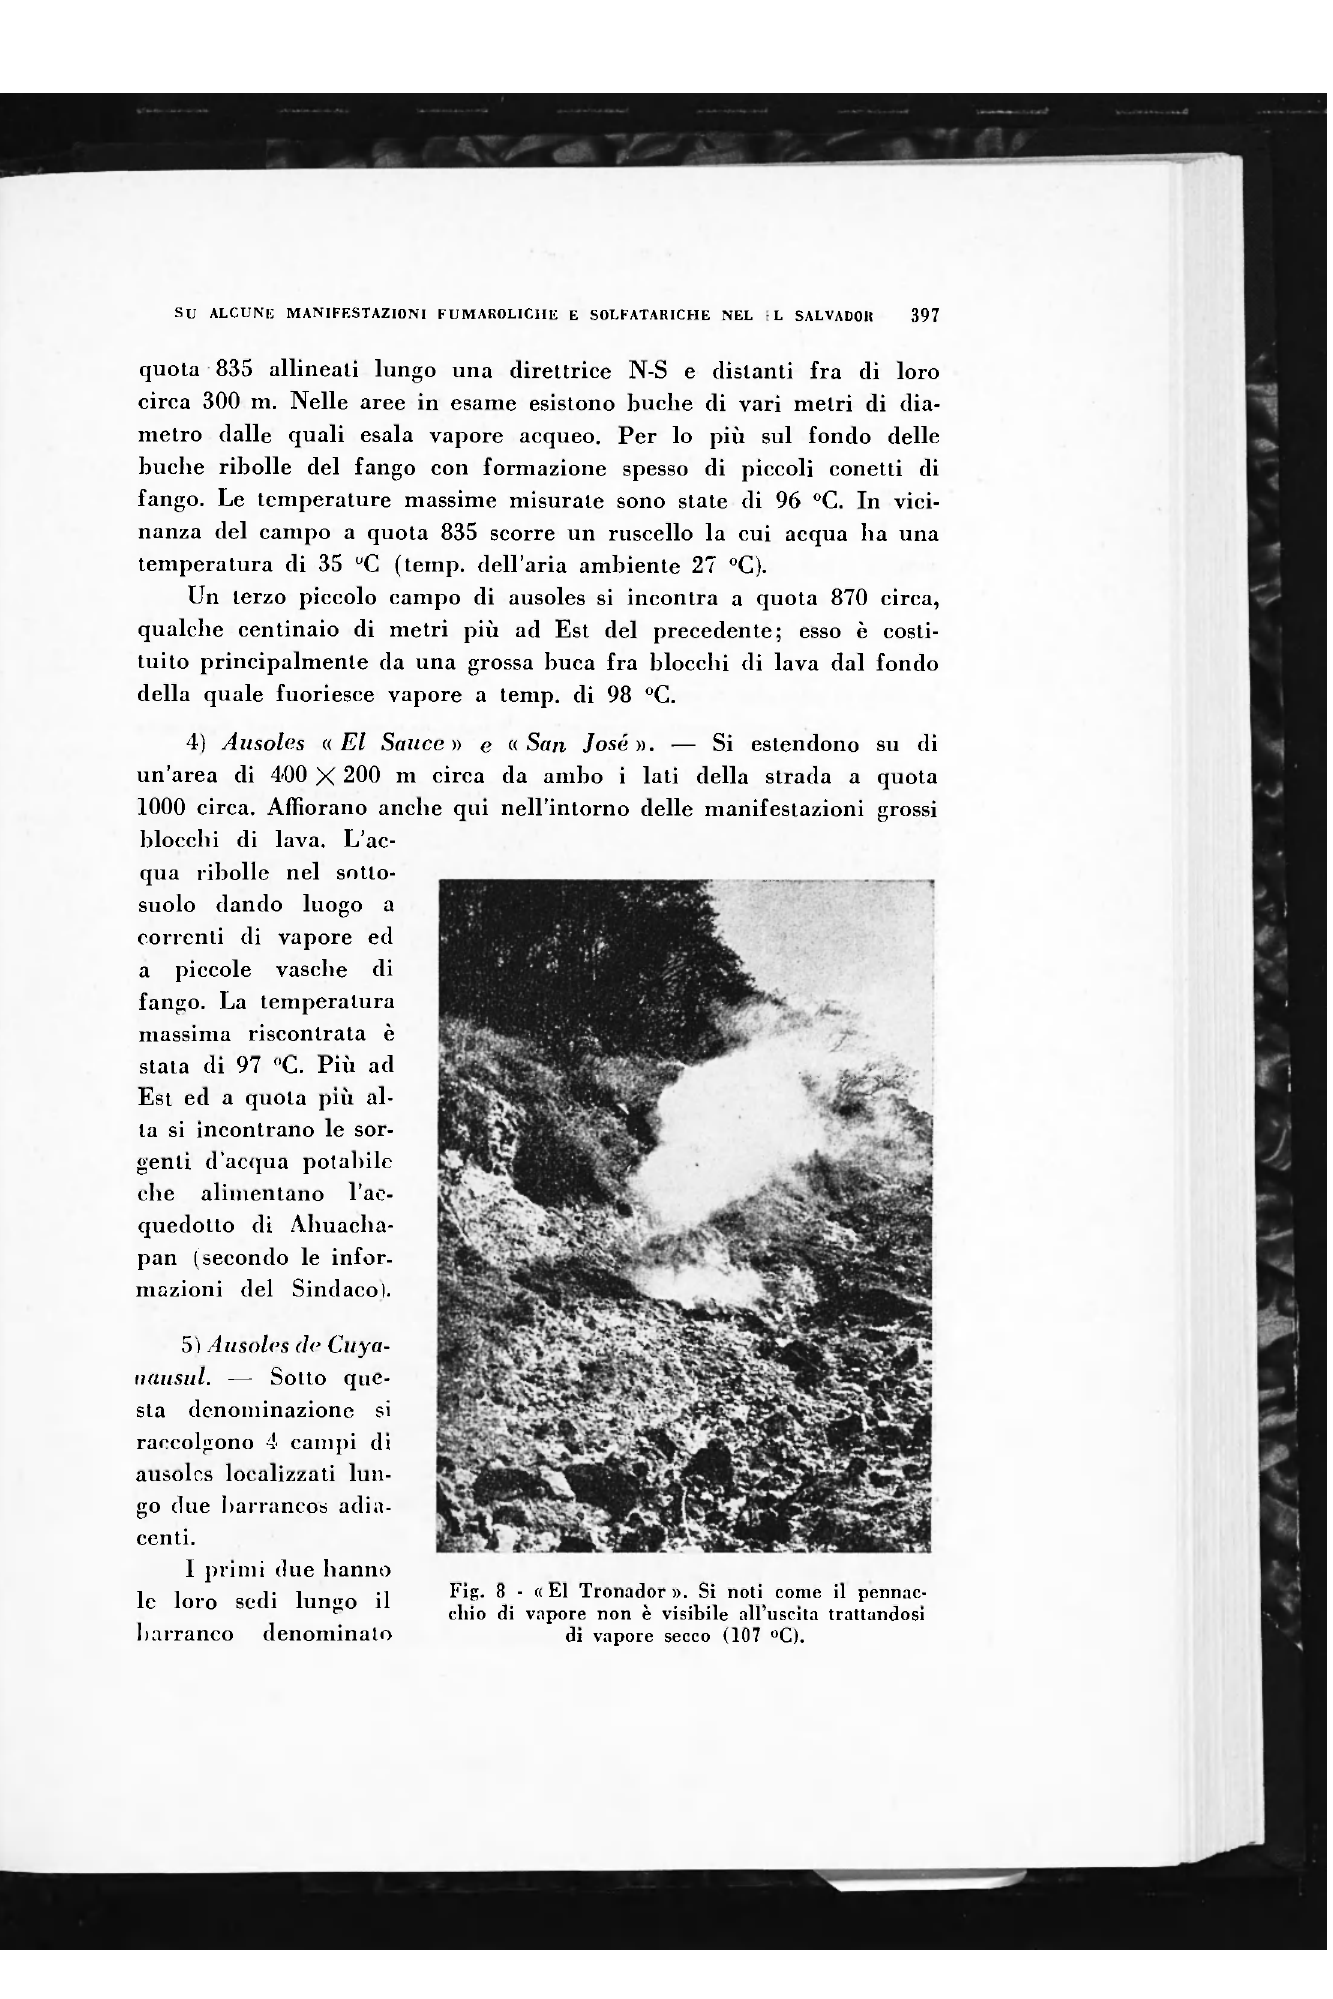
Fig. 8 - « El Tronador ». Si noti come il pennac- chio di vapore non è visibile all'uscita trattandosi di vapore secco (107